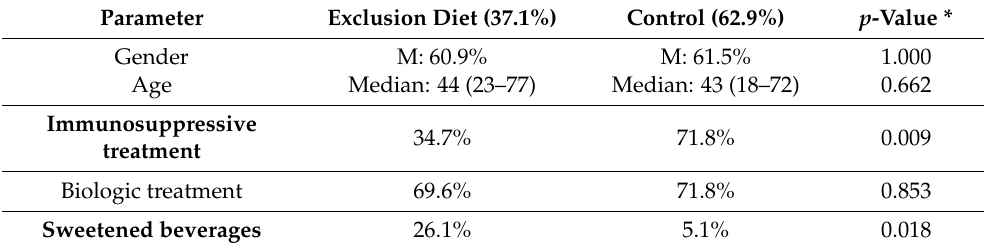
Table 3. Baseline characteristics for the UC subpopulation.